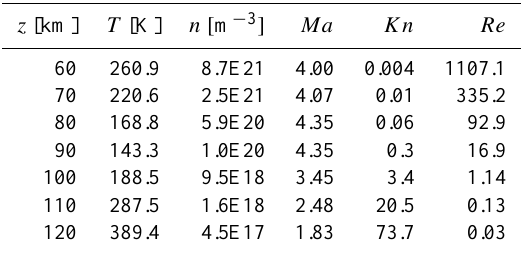
Table 2. Atmospheric and aerodynamic parameters during a sound- ing rocket flight in summer for an apogee of 130 km. Atmospheric temperatures and densities have been adopted from CIRA86 for the month July and 70 ◦ N (Fleming et al., 1990). z denotes altitude, T temperature, n number density, Ma the Mach number, Kn the Knudsen number, and Re the Reynolds number. Kn and Re have been calculated for L = 5 cm.